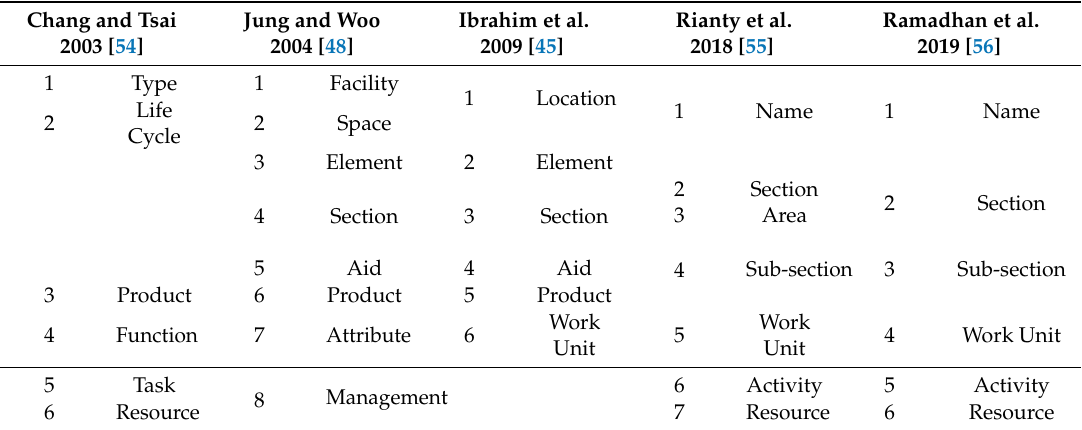
Table 3. Examples of decomposition criteria and level of detail for a WBS in the construction context. Chang and